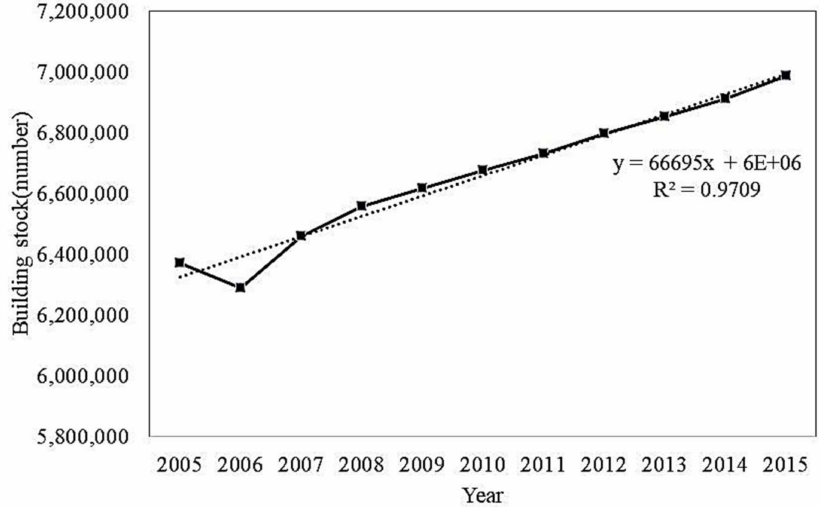
Figure 4. Increase in the number of building units by